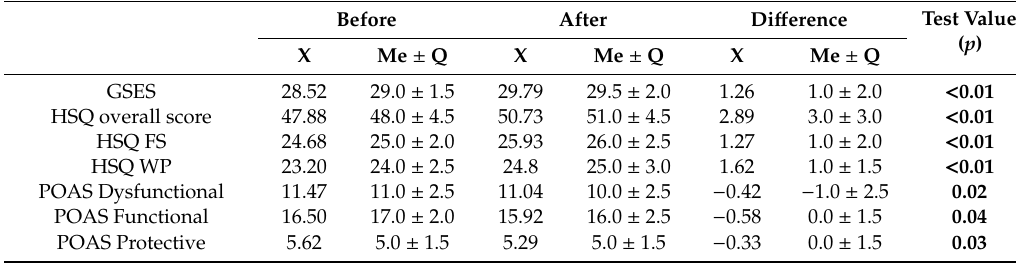
Table 4. Impact of the intervention on personality traits and aggression perception in male participants (n = 70).